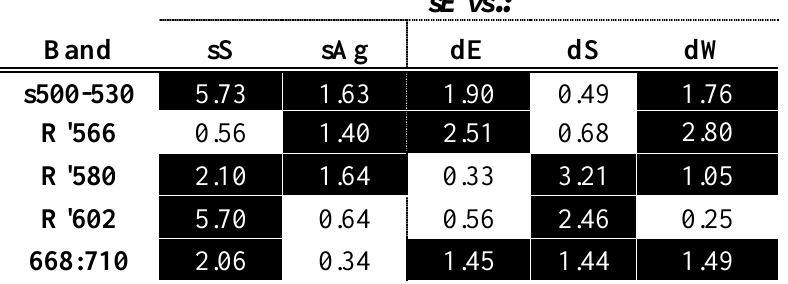
Table 5. Set 2 (DA result) variable set showing spectral separability of shallow eelgrass (<3 m) from other benthic substrates from above water. A dark box represents good separability (M-statistic > 1) and an empty box denotes poor separability (M-statistic < 1). The value in the box is the M-statistic result. sE vs.: